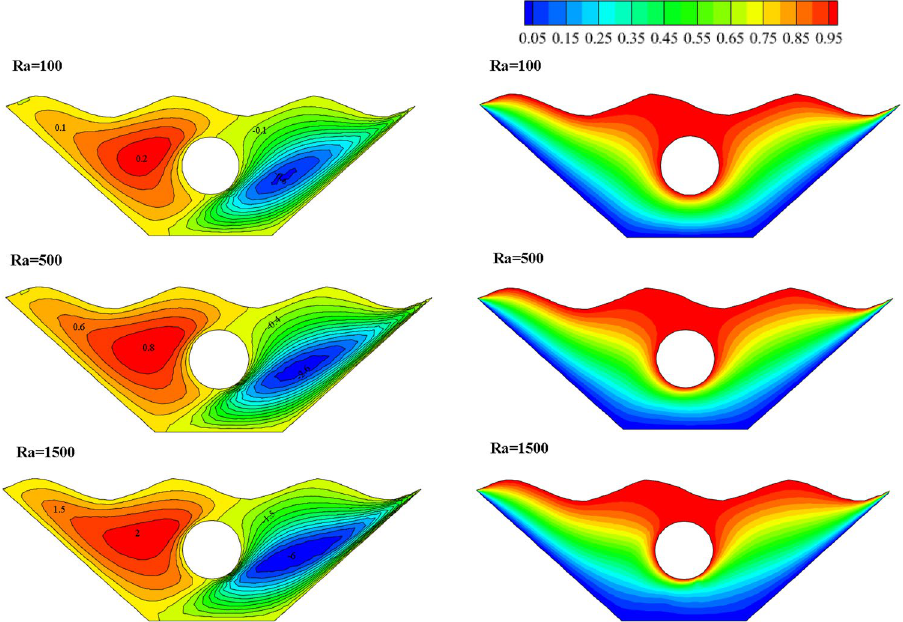
Figure 11. Stream functions and Isotherms for different values of Rayleigh numbers (Ra) at ℇ = 0.7, Ha = 20, Rd = 0.5 and α = π/6.